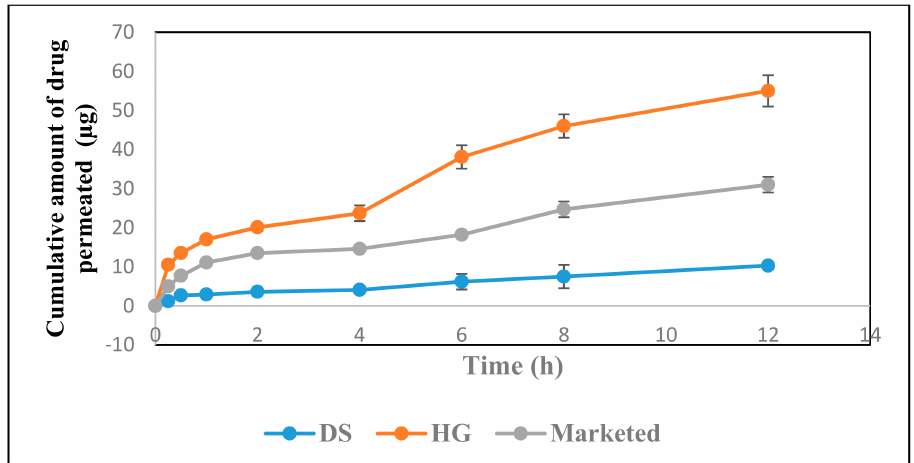
Figure 6. Cumulative amount of drug permeated vs. time profile.